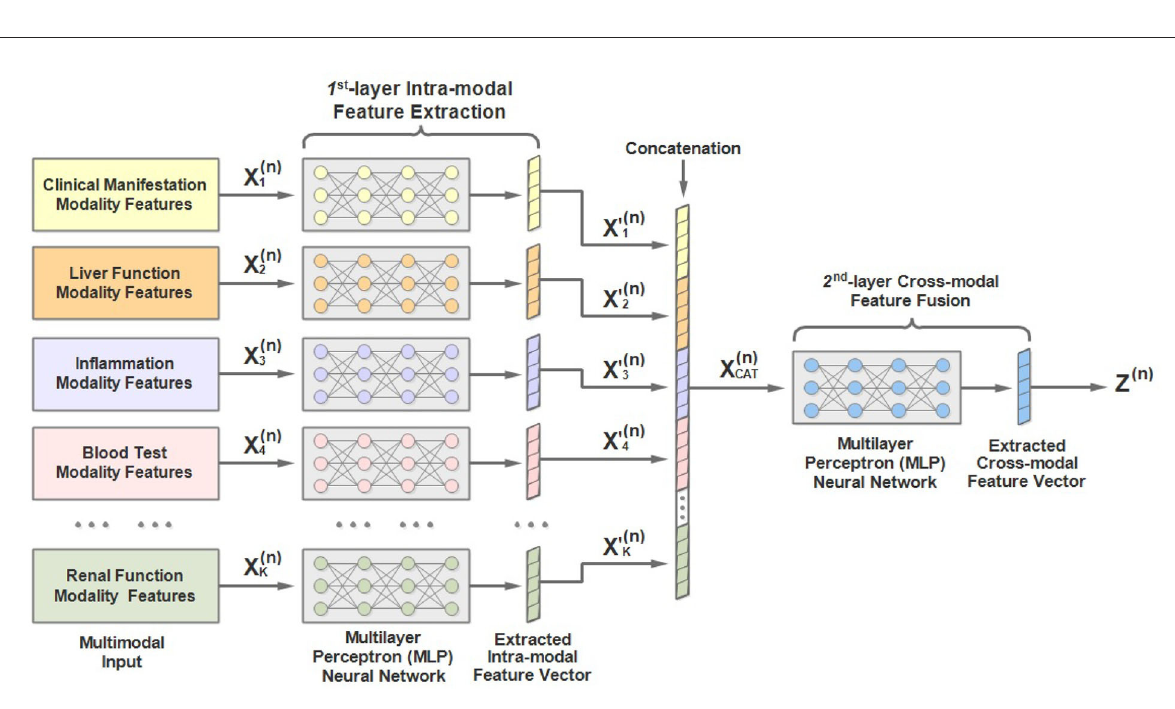
FIGURE4 An illustration of the architecture of multimodal feature extractor of the MMDL